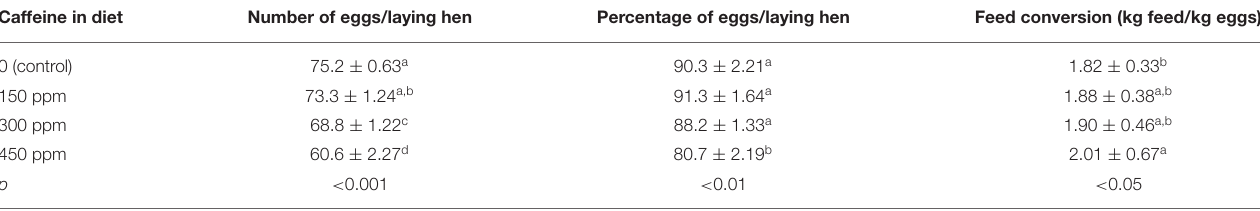
TABLE 3 | Number and percentage of produced eggs per laying hen and feed conversion in eggs (in g/egg) of hens fed rations containing different concentrations of caffeine for 12 weeks. Caffeine in diet Number of eggs/laying hen